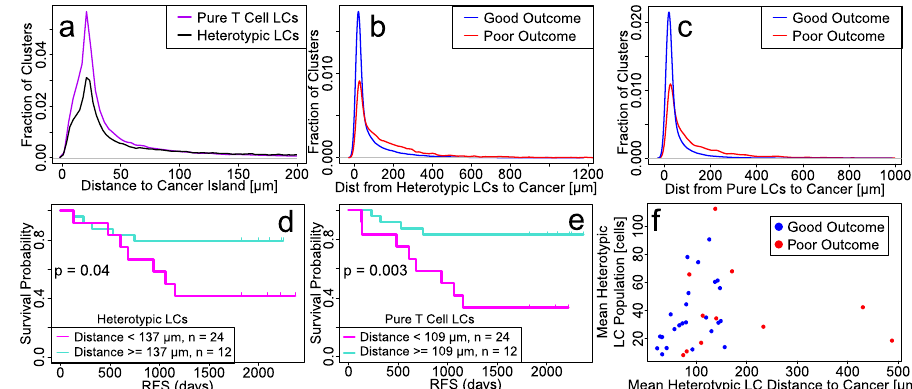
Fig. 7 LCs are closer to cancer cell islands in good outcome. a Distribution of distances from LCs to cancer islands shows pure T LCs tend to be closer to cancer islands than heterotypic LCs. Distribution of mean distances between an LC and its nearest cancer cell island shows that ( b ) heterotypic and ( c ) pure T cell LCs are closer on average to cancer cell islands in good outcome. RFS plots showing the clinical signi fi cance of mean distance between ( d ) heterotypic or ( e ) pure T cell LCs and the nearest cancer cell island. (See “ Methods ” for how RFS thresholds were chosen.) f Smaller heterotypic LCs tend to be closer to cancer cell islands in the good outcome as shown in the scatter plot of the average size (number of cells) of LCs vs. the shortest distance between a heterotypic LC and the nearest cancer cell island. Each point represents a patient. Blue is for good outcome and red is for poor outcome. Pearson ’ s r = 0.42, p = 0.04 for good outcome indicates signi fi cant correlation while r = 0.09, p = 0.6 for poor outcome. Patient cohorts for all panels in this fi gure are n = 24 for good outcome (blue) and n = 12 for poor outcome (red). Computation of mean distance used in plots: The mean distance is found for each patient and then the average over all patients is calculated to produce the mean